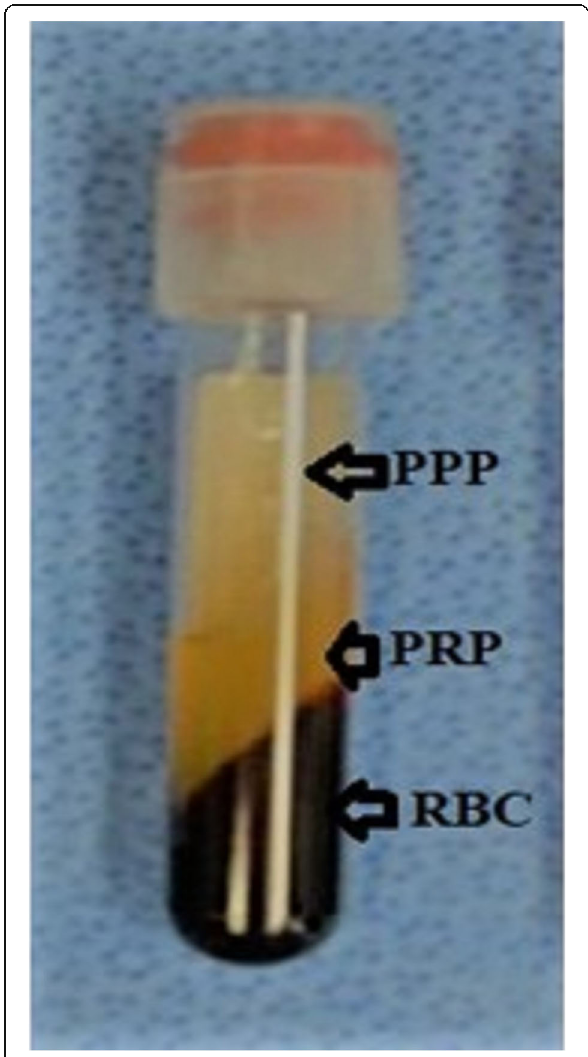
Fig. 2 Centrifuged blood into red blood cells (RBCs), platelet-rich plasma (PRP), and platelet-poor plasma (PPP)